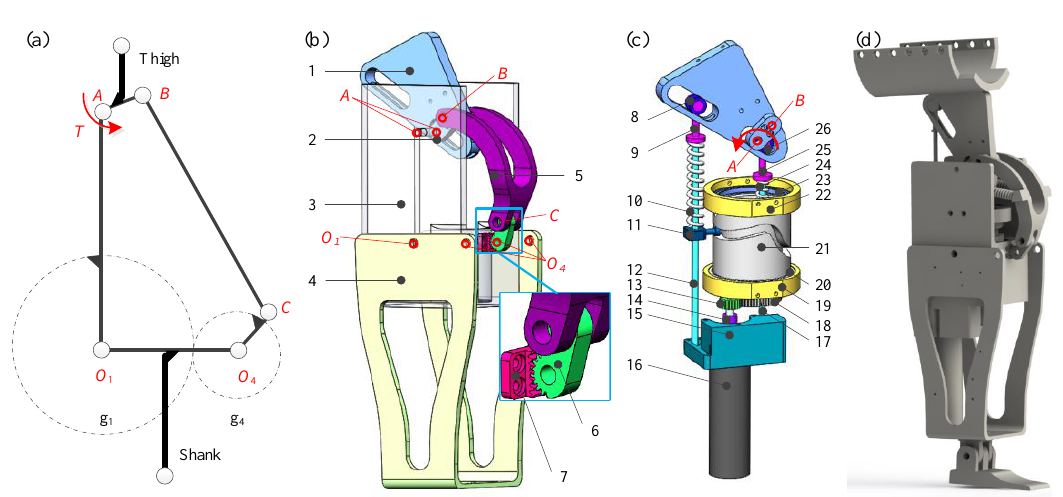
Figure 1. ( a ) Schematic diagram, ( b ) structure, ( c ) actuation mechanism, and ( d ) CAD model of the GFB prosthetic knee. 1-level arm (fixed on linkage 𝐴𝐵 ), 2-linkage 𝐴𝐵 (thigh linkage), 3-linkage 𝑂 1 𝐴 (frame), 4-linkage 𝑂 1 𝑂 4 (shank linkage), 5-linkage 𝐵𝐶 , 6-linkage 𝐶𝑂 4 (incomplete gear g 4 centered at hinge 𝑂 4 ), 7-incomplete gear g 1 (fixed on linkage 𝑂 1 𝐴 ), 8-bearing, 9-spring fastening, 10-helical spring, 11-cam roller, 12-guide, 13-transmission gear, 14-coupling, 15-motor cabinet(fixed on frame), 16-motor, 17-guide, 18- transmission gear, 19-bearing chock, 20-bearing, 21-cylindrical conjugate cams(two cam grooves on outer/inner walls of the cylinder), 22-bearing chock, 23-bearing, 24-helical spring, 25-spring fastening, 26-bearing.